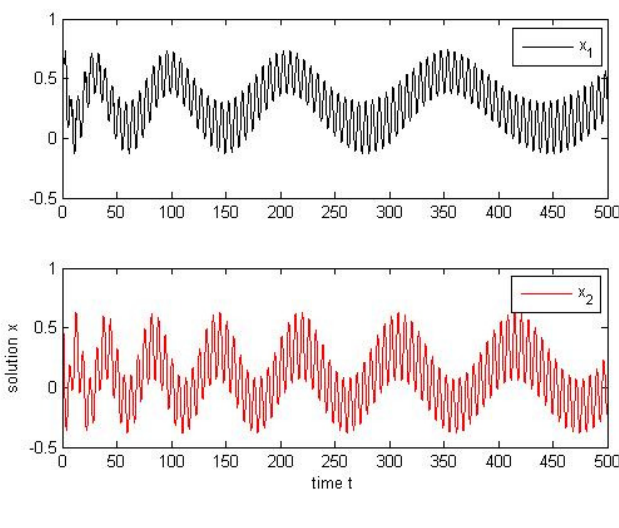
Figure 1. Curve of pap solution of